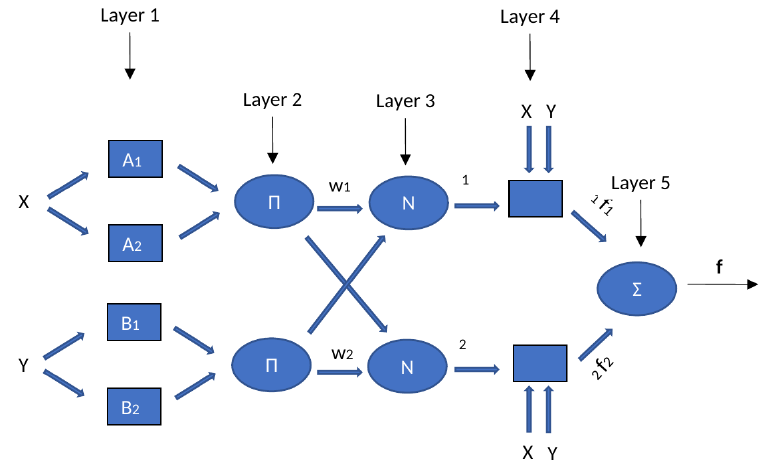
Figure 1. Two-input structure of ANFIS.